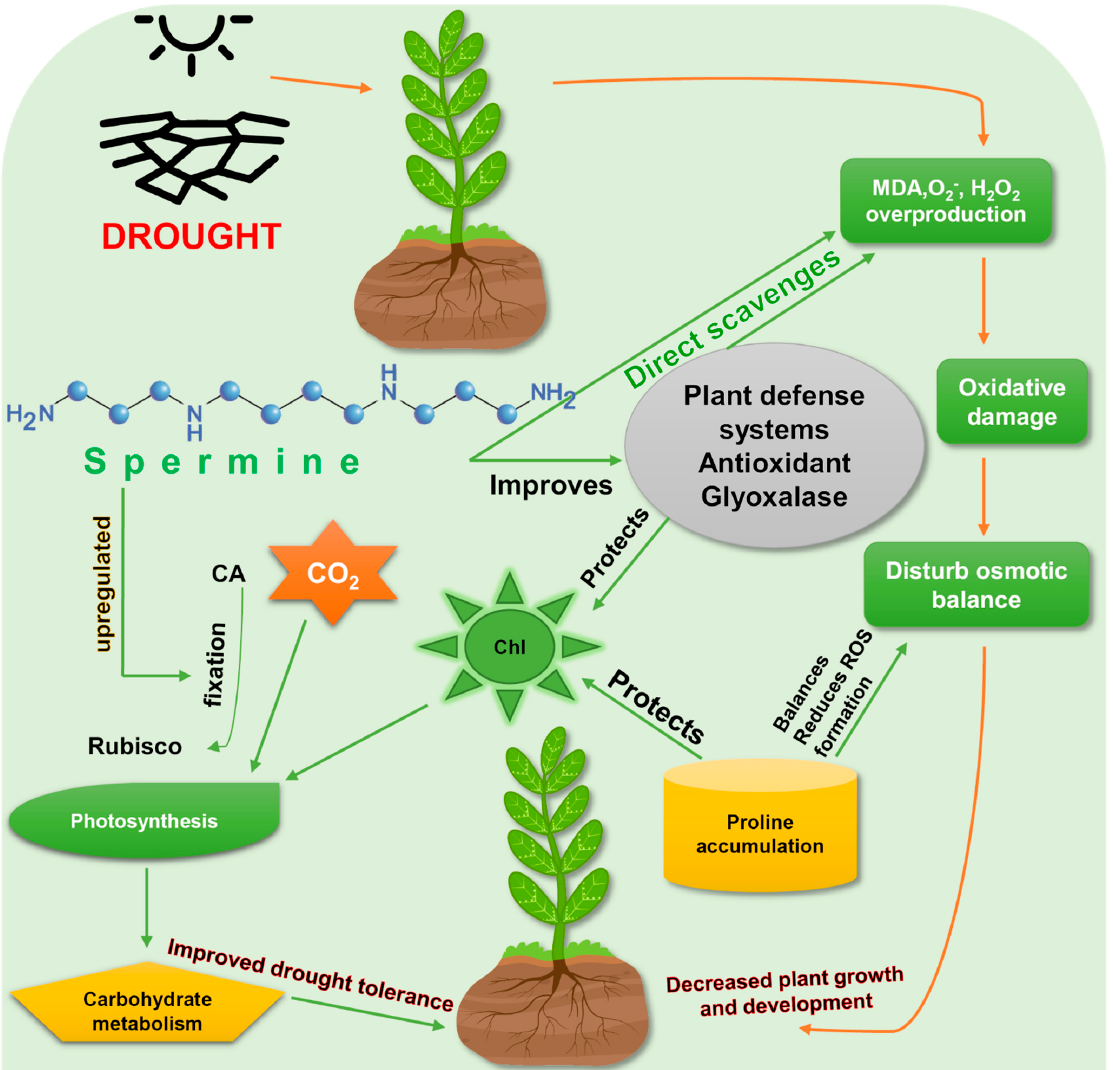
Figure 2. Enhancement of drought-stress tolerance by spermine. Exogenous application of spermine improves the drought tolerance in plants. Rubisco, ribulose-1,5-bisphosphate carboxylase/oxygenase; MDA, malondialdehyde; ROS, reactive oxygen species; Chl, chlorophyll; CO 2, carbon dioxide; CA, carbonic anhydrase. Green arrows represent spermine’s actions to reduce drought stress, while red arrows show the direct effects of drought on plants.